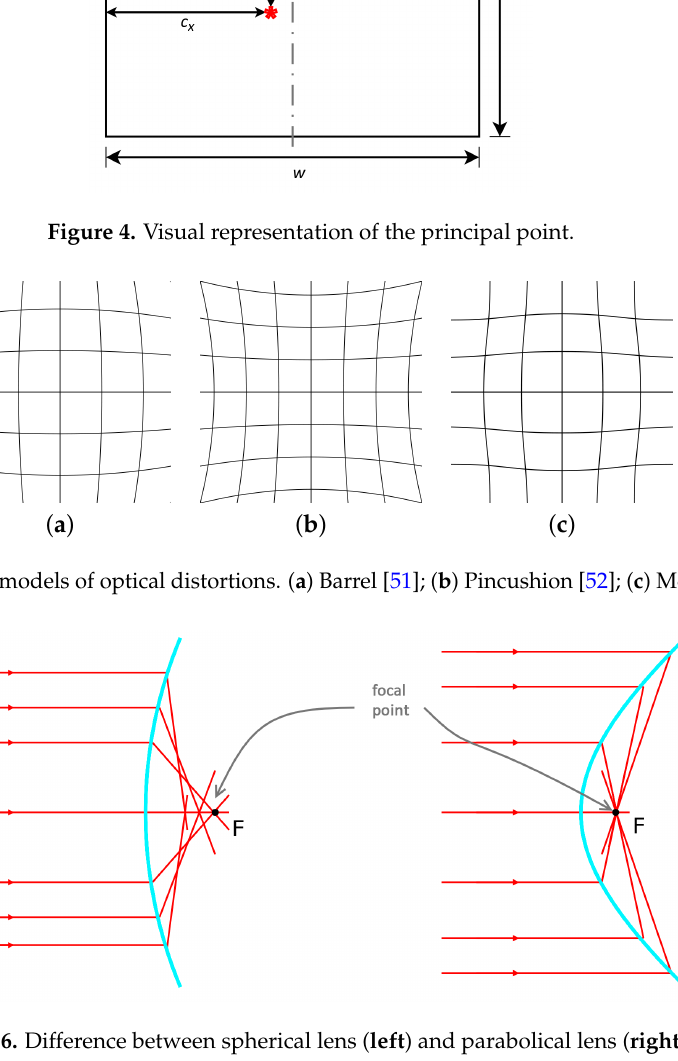
Figure 6. Difference between spherical lens ( left ) and parabolical lens ( right